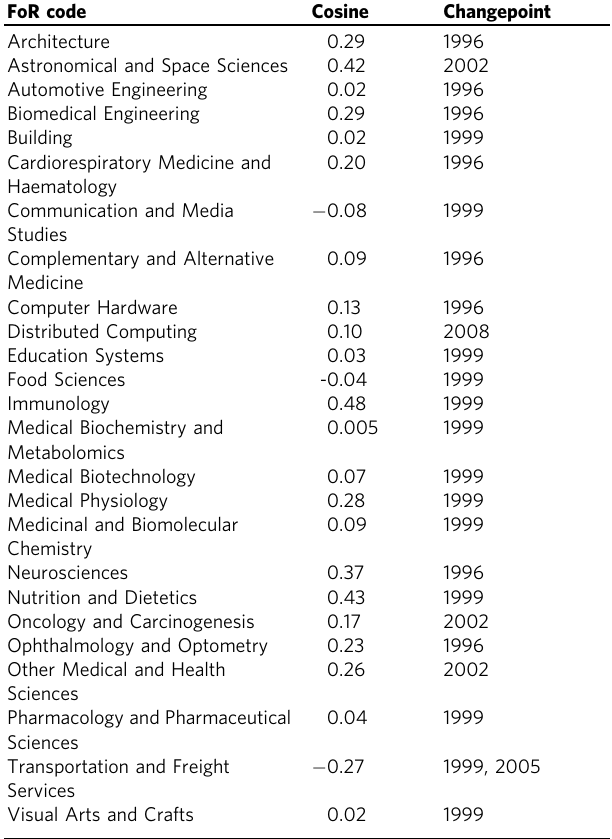
Table 4 List of disciplines whose pro fi les have changed between 1990 and